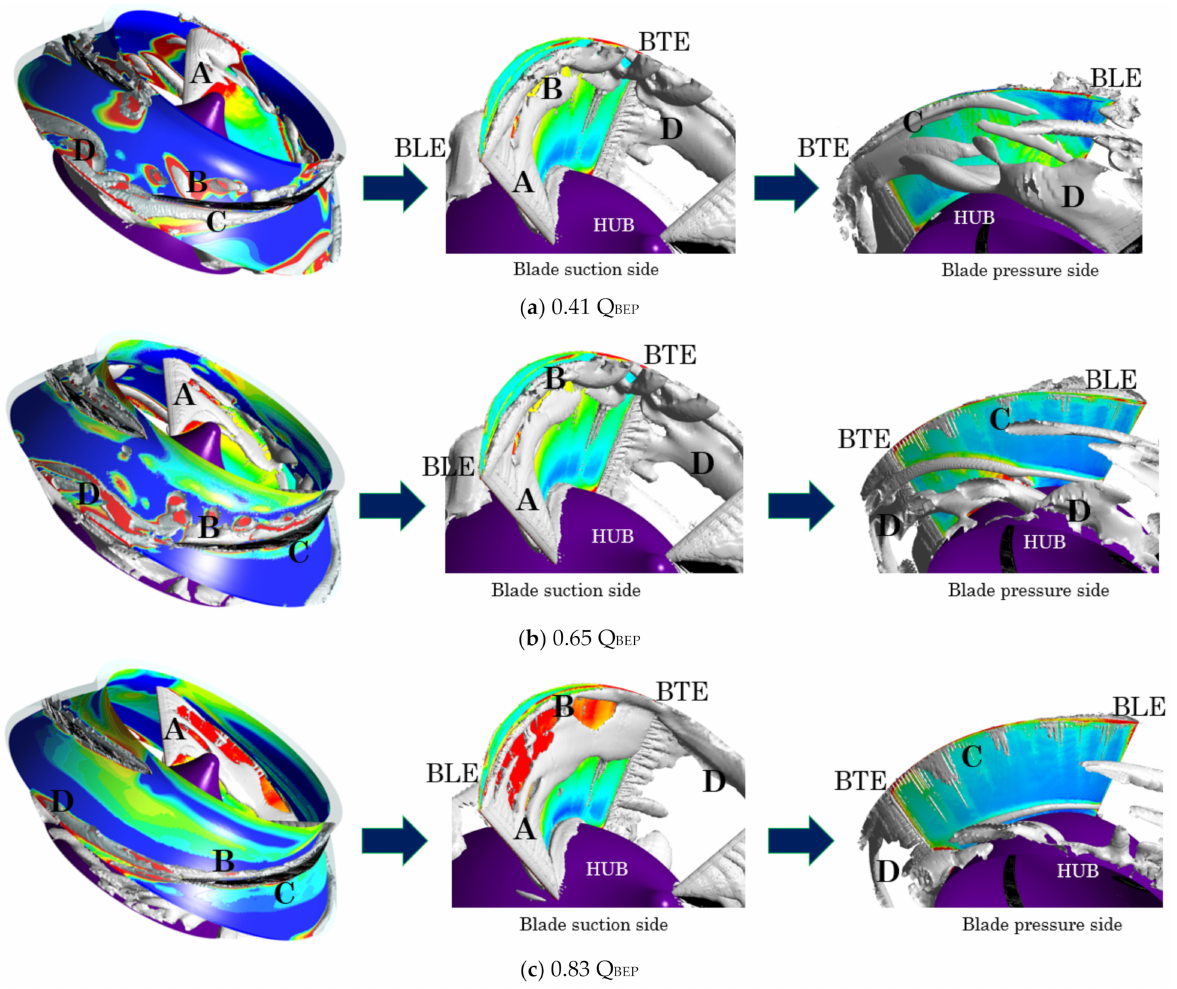
Figure 11. Main flow vorticity zones within the runner for different flow conditions. Under upper part-load conditions, it again moves downwards to the runner hub’s vicinal zone and maintains a string-like form extending from the BLE to the ROZ. For the sake of analyzing the flow dynamics within inter-guide vane (GV) flow channels, the next four figures (Figures 12–14) give a visual of both velocity contours and corresponding velocity-colored streamlines within the diffusor flow zone for different operating conditions. To do so, three consecutive planes, SG1, SG2, and SG3, were selected in the streamwise direction at positions 1.15, 1.55, and 1.95, considering positions at the diffuser inlet and the diffuser outlet as 1 and 2, respectively. Under 0.41 Q BEP operating conditions, SG1, being the closest to the vaneless space between the runner and diffuser, exhibits a huge zone of very low flow velocity, expanding from the hub to beyond the mid-span zone and a narrow high-speed flow right at the diffuser’s shroud